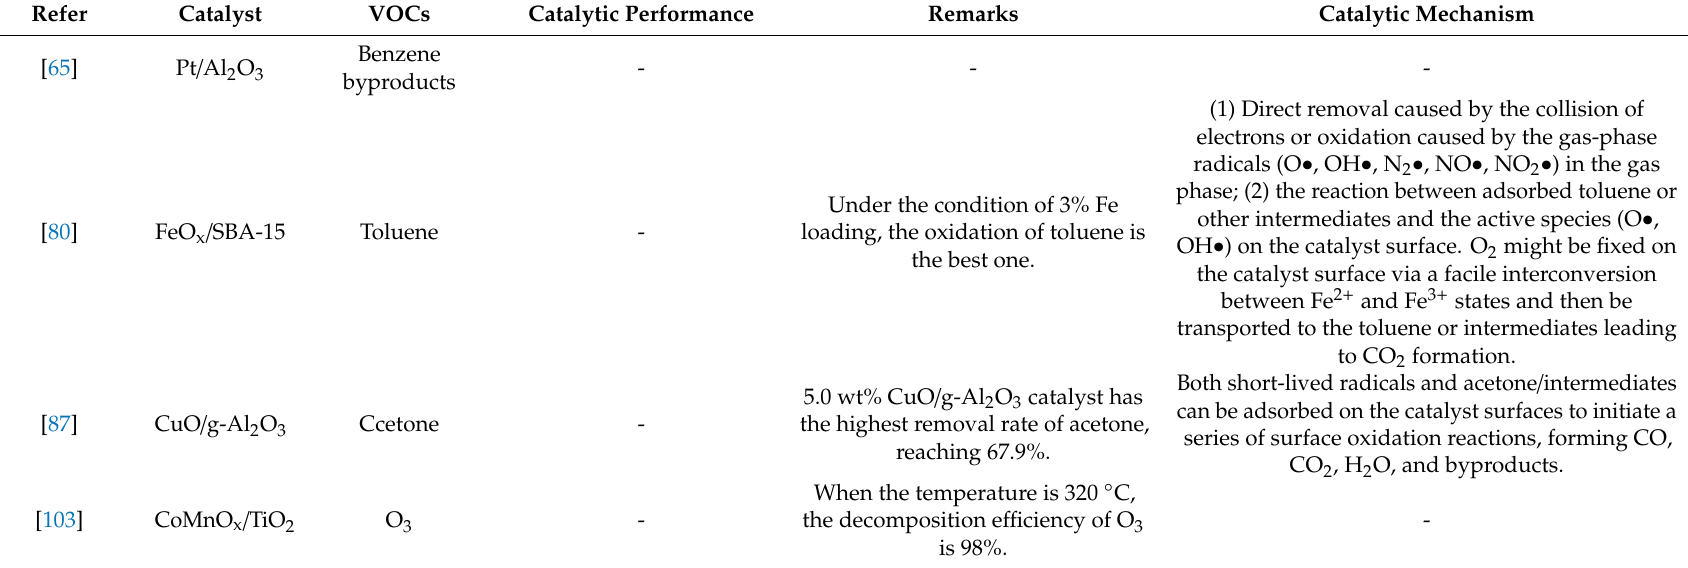
Table 10. Catalysts for VOCs elimination through the non-thermal plasma